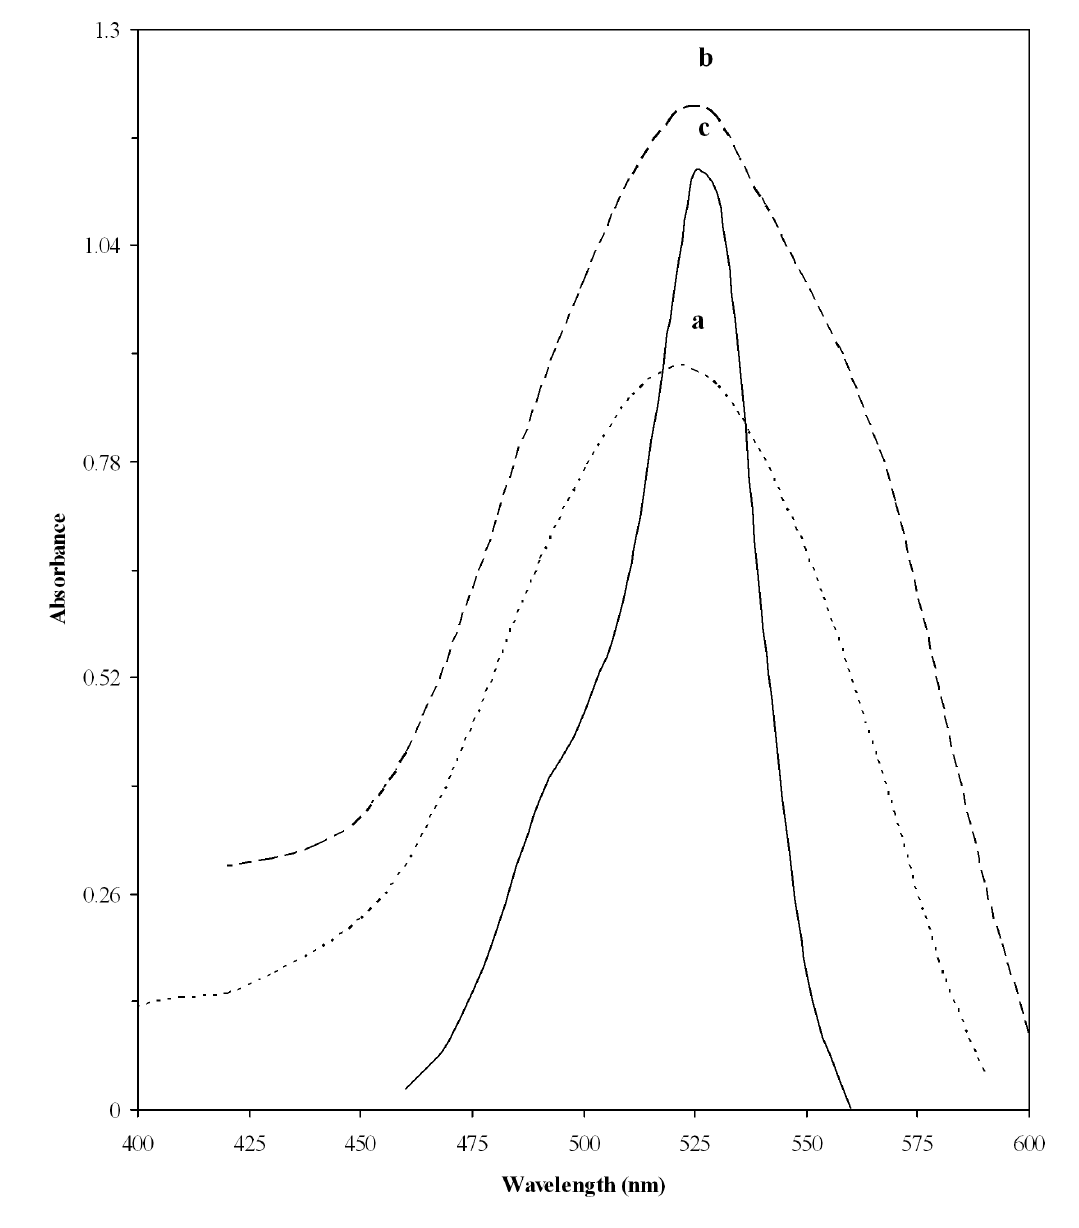
Fig. 1 Absorption spectra for the reaction product of 9.0 µ g ml − 1 DIL.HCl with: (a) NBS-AM, (b) Ce 4+ - C2R, (c) Ce 4+ -